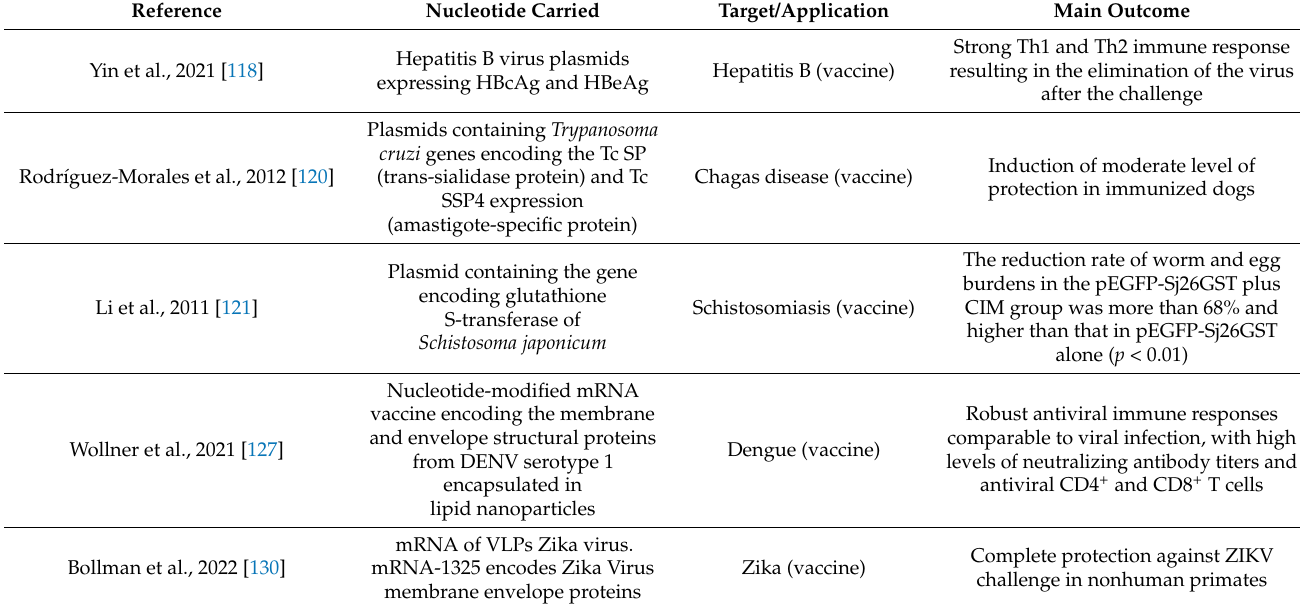
Table 5. Nucleic acids and liposomes in the prevention of neglected tropical